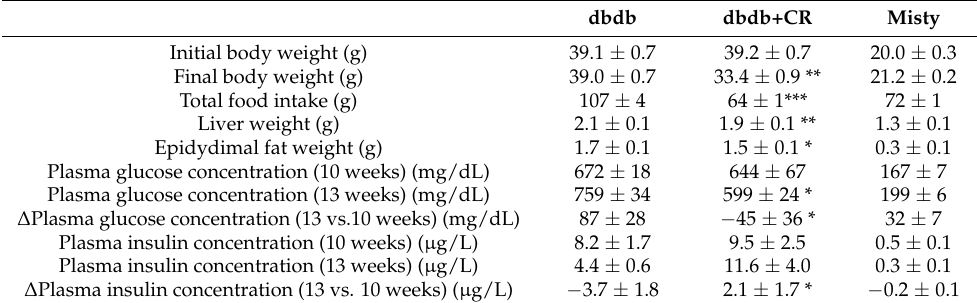
Table 1. Body weight, total food intake, liver weight, epididymal fat weight, and concentrations of plasma glucose and insulin in mice.